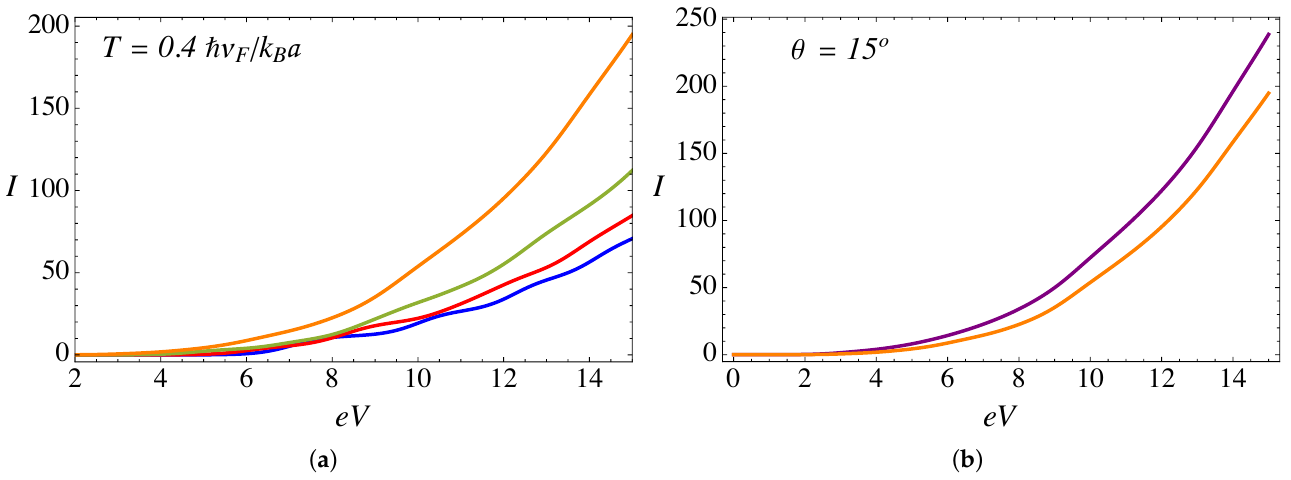
Figure 7. (Color online) ( a ) Electric current (in units of ev F / a ) plotted as function of applied bias eV (in units of ¯ hv F / a ), computed from the analytical expression in Equation (9) at T = 0.4 ¯ hv F / k B a , for an external magnetic field B 0 a 2 = 25 ˜ φ 0 and α = 3 π /4. The blue line corresponds to a twist angle θ = 0 ◦ , red is for θ = 5 ◦ , green is for θ = 10 ◦ , and the orange line corresponds to θ = 15 ◦ . ( b ) Comparison of electric currents at T = 0.4 ¯ hv F / k B a , for B 0 a 2 = 25 ˜ φ 0 and θ = 15 ◦ : the purple line is for α = 0 and orange corresponds to α = 3 π /4.